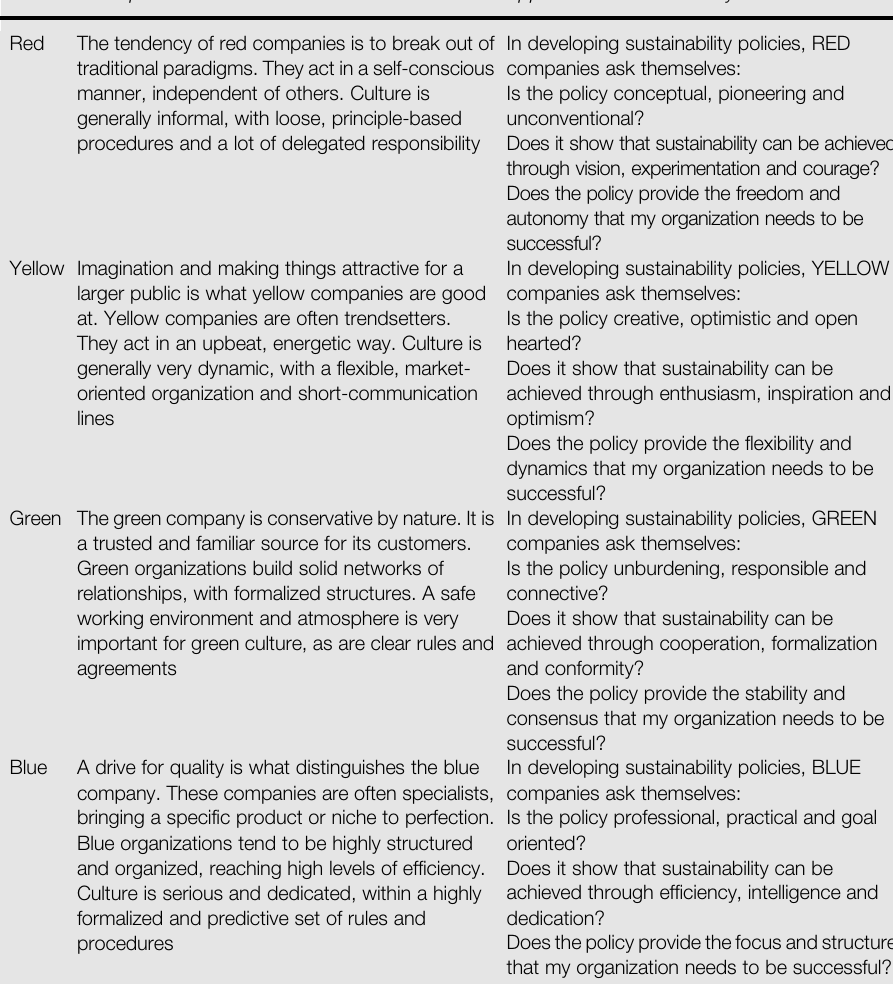
Table II Four types of organizational DNA clarified DNA Description Application to sustainability